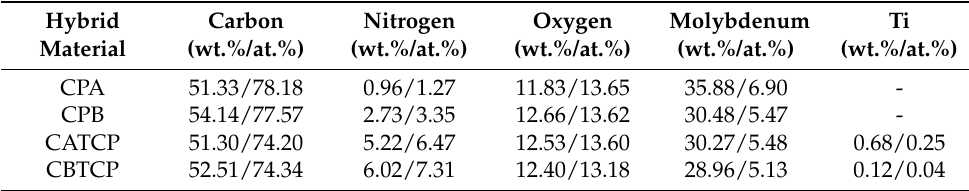
Table 4. EDS analysis of TFN